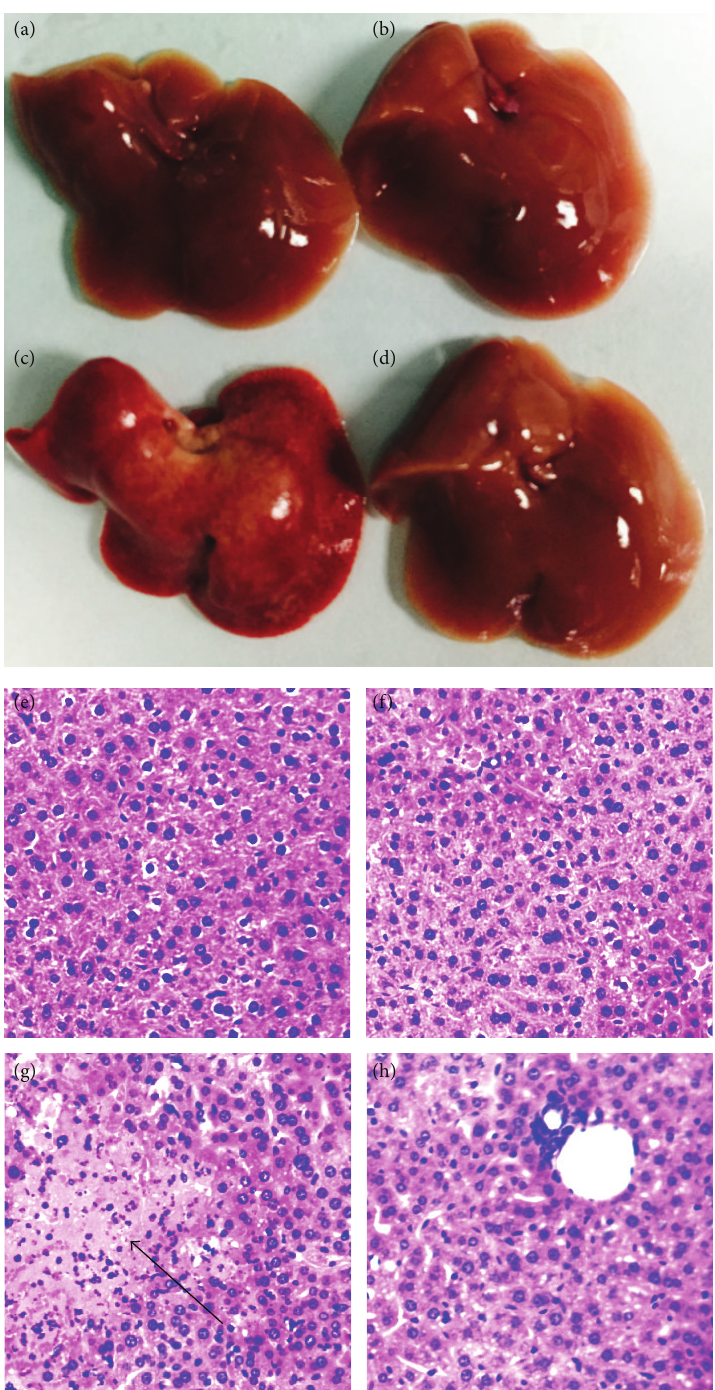
Figure 3: DH inhibits ConA-induced hepatitis. Notes: mice were injected i.p. with DH (20 mg/kg of body weight) at 2h before the challenge of ConA (15mg/kg of body weight). Mice were sacrificed at 24 hours after the ConA injection. The livers were harvested from Control (a), DH (b), ConA (c), and ConA+DH (d) injection mice, respectively. Liver tissues from Control (e), DH (f), ConA (g), and ConA+DH (h) groups were fixed and stained with hematoxylin and eosin (H&E). The arrow indicates massive cell death in the liver section. Original magnification × 200. i.p. : intraperitoneal injection; ConA: Concanavalin A; DH: Dracocephalum heterophyllum ; H&E, hematoxylin and